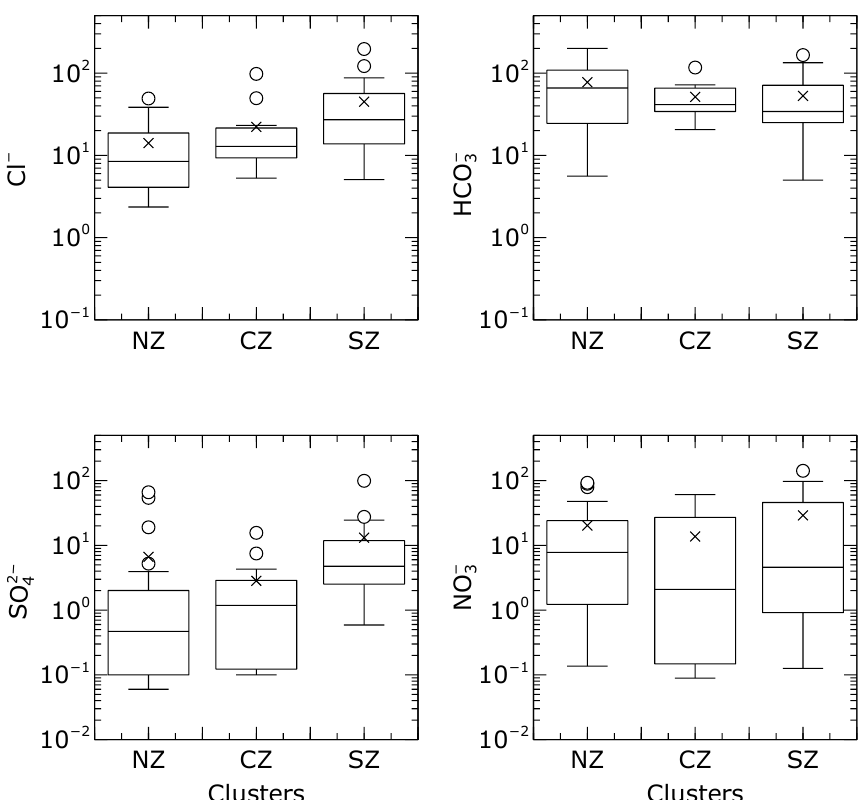
Figure 9. Box- and-whisker plots highlighting the variations in the major anions (HCO − and NO − ) in groundwater for the three identified zones. The horizontal solid line and the x symbol 3 on the box-and-whisker plot represents the average and the median concentrations, respectively. Outliers are defined by points that fall more than 1.5*IQR above the third quartile or below the first quartile. NZ, CZ and SZ denote the northern zone, central zone and southern zone, respectively. All chemical parameters are measured in